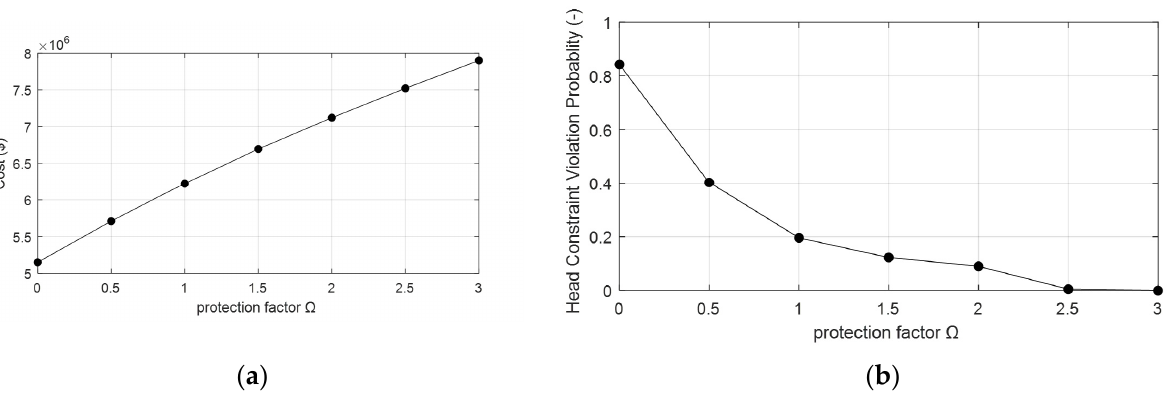
Figure 9. Results of uncorrelated optimization for Fossolo network: ( a ) cost vs. protection factor Ω ; ( b ) head constraint violation probability.